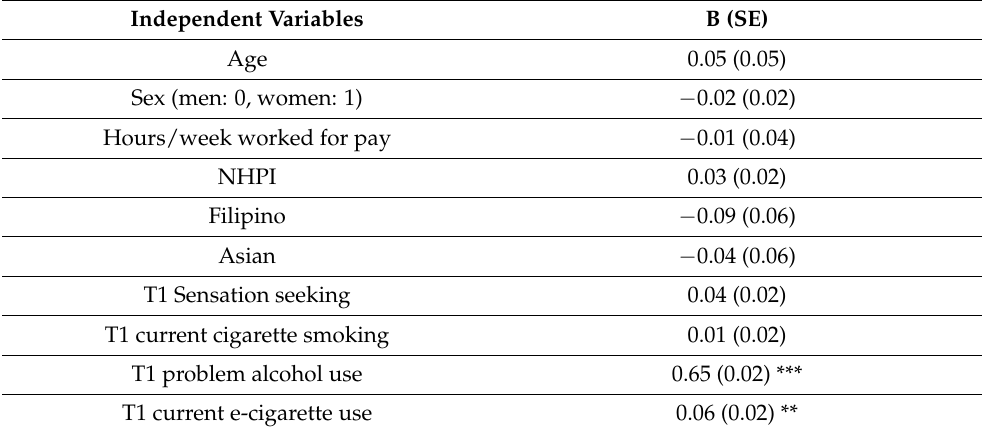
Table 2. The effects of baseline e-cigarette use on problem alcohol use at six-month follow-up. Independent Variables